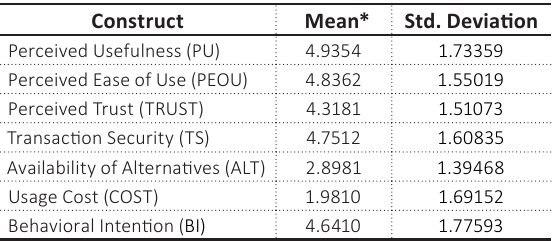
Table 4. Mean comparison for